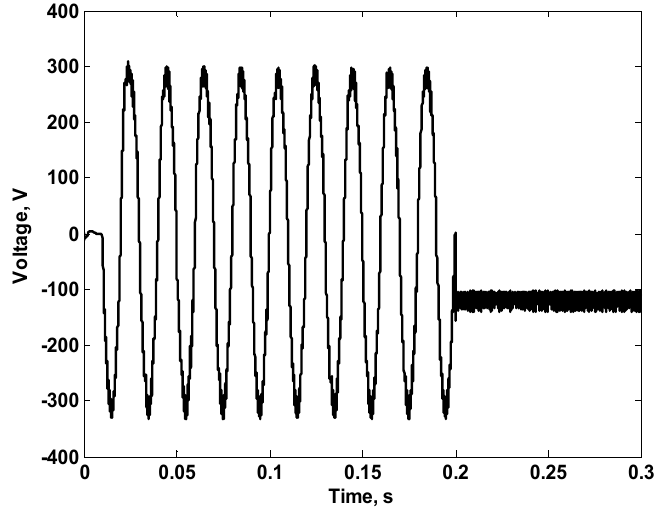
Figure 17. Output Voltage with − ve DC transfer at Converter Terminals.